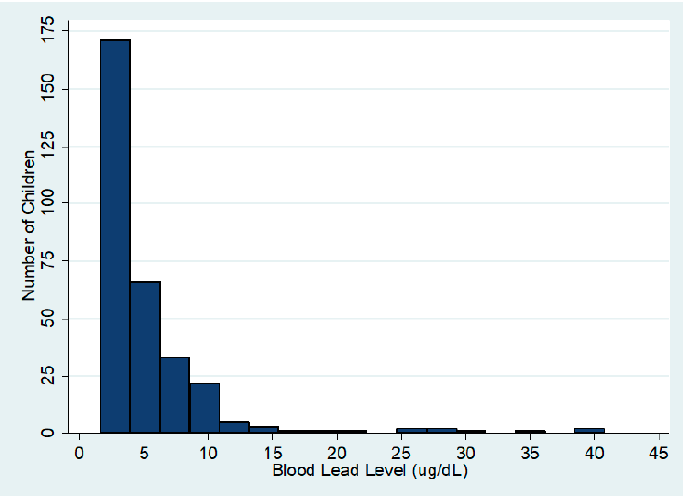
Figure 1. Distribution of blood lead levels (BLLs) ( n = 311).